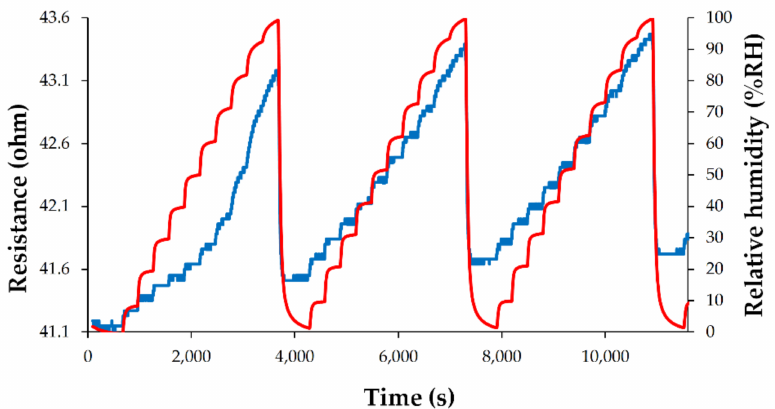
Figure 11. The response of the sensor T3 (the blue curve) as a function of time for the three measure- ment cycles when RH varies between 0% and 100%. The “RH curve-red” shows the variation of the RH in the testing chamber, as indicated by the reference